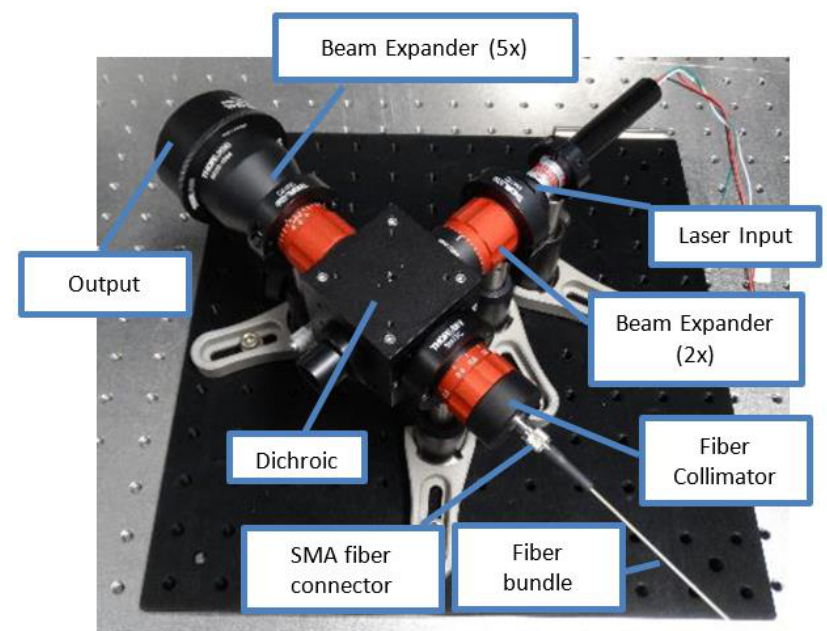
Figure 4. Optical head assembled from COTS components.